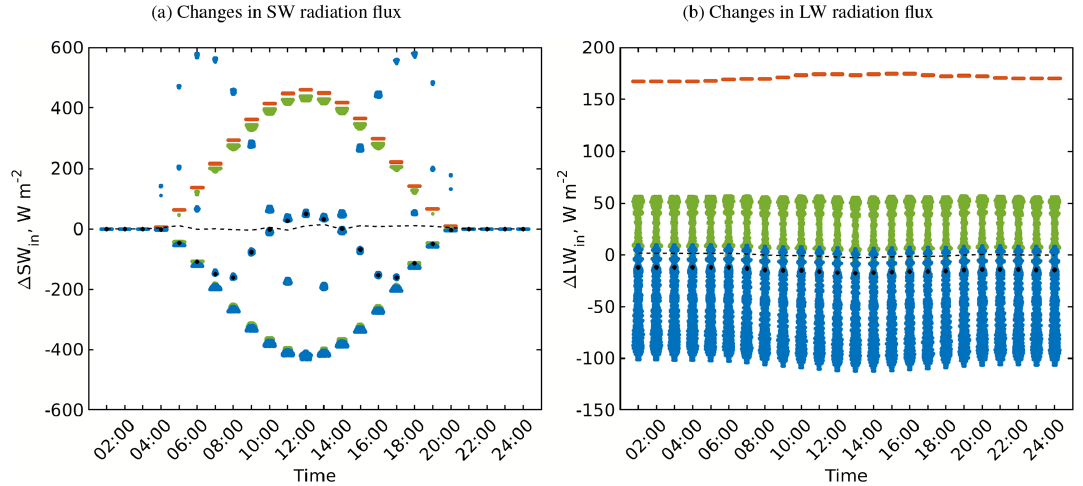
Figure 5. Changes in the received SW and LW irradiance within the focus domain of the simple urban configuration when considering the surface sky-view factors (RTM_02) compared to the RTM_01. The roof, the wall, and the ground surfaces are shown in the violin plots in orange, blue, and green, respectively. Similar to Fig. 4, the mean values are shown by a dashed black line and the median values are shown by black circles.